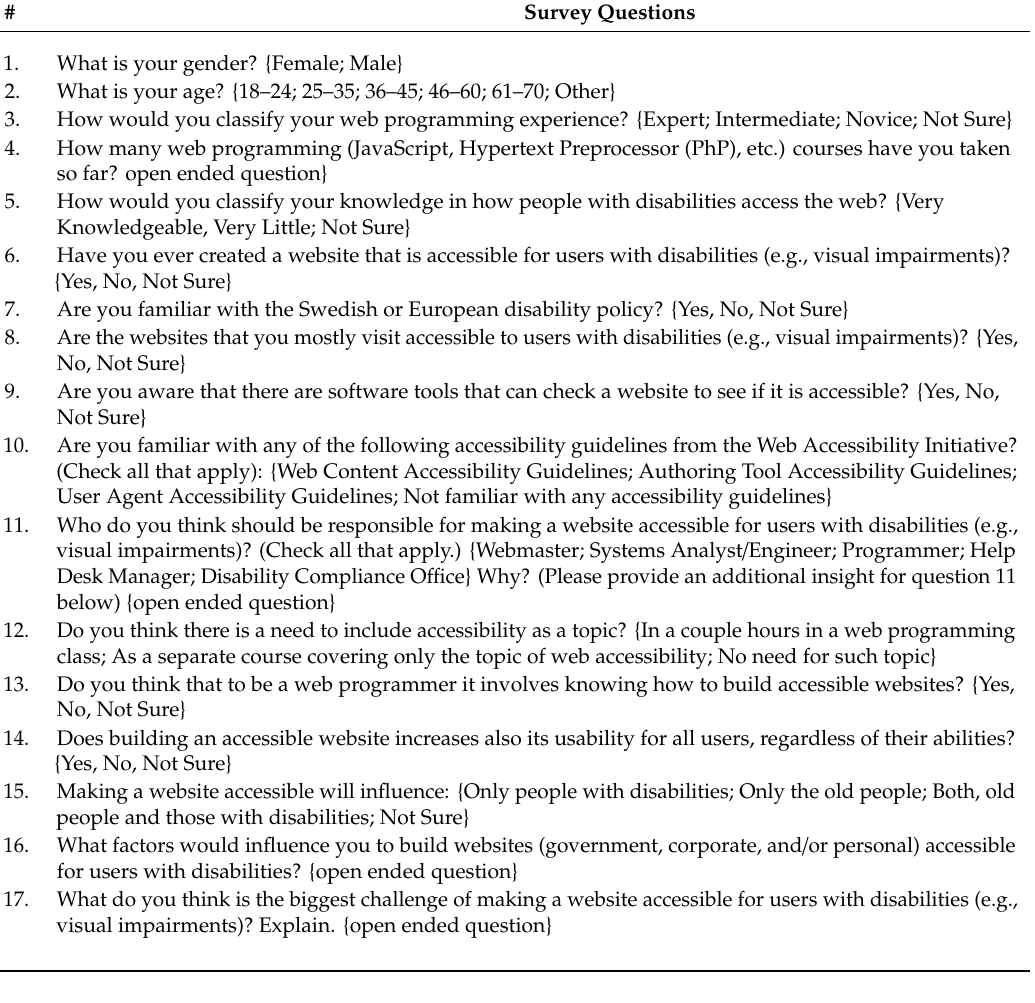
Table 4. Interview